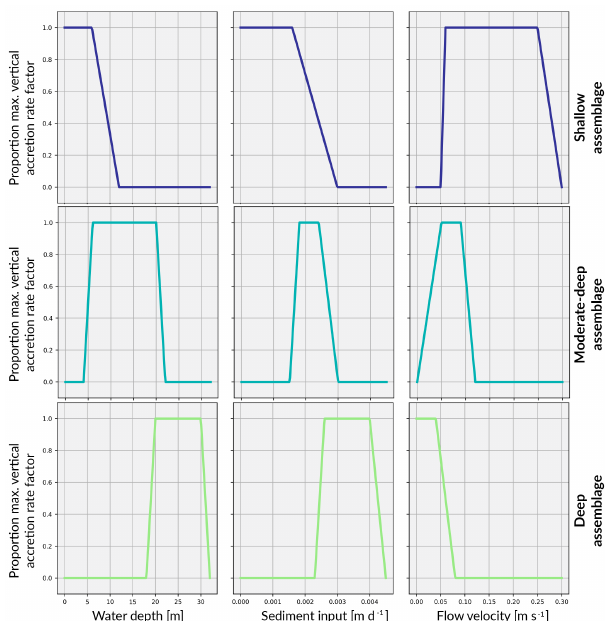
Figure 3. Environmental threshold functions for shallow, moderate–deep and deep assemblages characteristic of a syn- thetic exposed margin. The x axis indicates the limitation on maximum vertical accretion for conditions outside the optimal maximum vertical accretion rate.